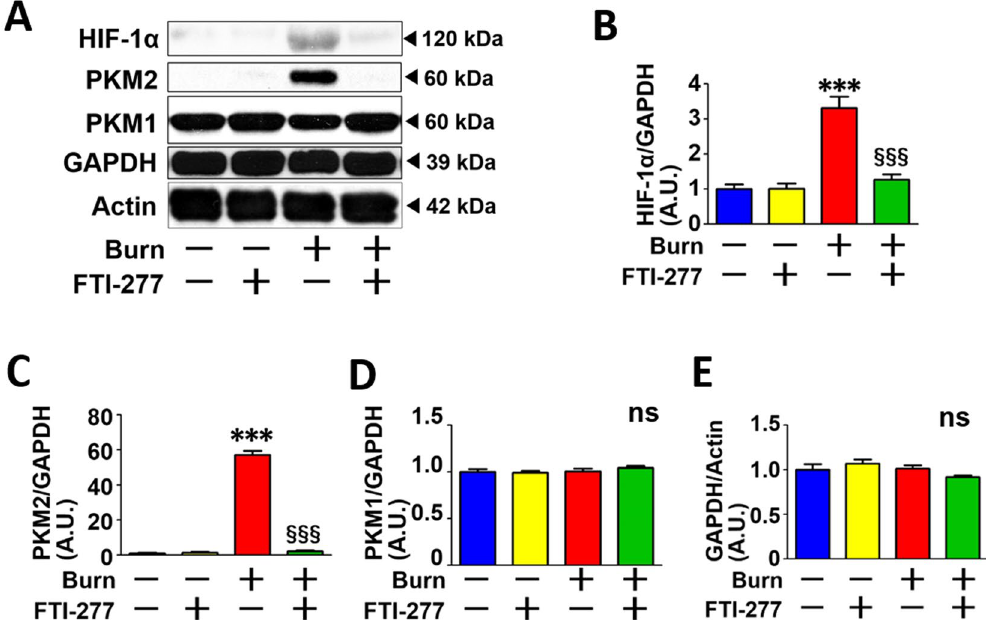
Figure 2. FTI-277 treatment reversed burn-induced activation of the HIF-1 α pathway in skeletal muscle. Burn injury significantly increased HIF-1 α and PKM2 protein expression in mouse skeletal muscle at 3 days post- burn. FTI-277 treatment reversed burn-induced increased HIF-1 α and PKM2 expression ( A – C ). PKM1 and GAPDH protein expression was not altered by burn injury or FTI-277 treatment ( A , D and E ). *** P < 0.001 vs. sham-burn groups, §§§ P < 0.001 vs. vehicle-treated burn group. ns: not significant. n = 6 mice per group.